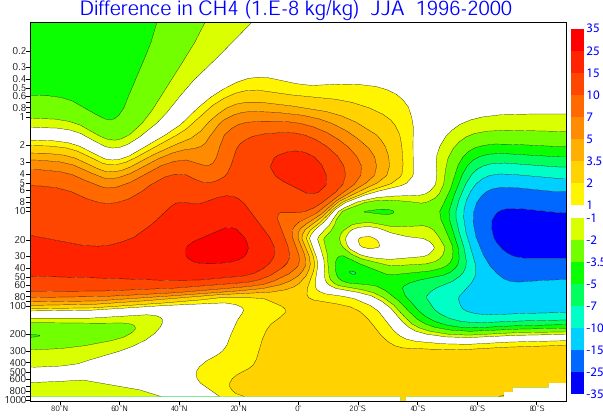
Fig. 11. Differences in the CH 4 concentrations (10 − 8 kgkg − 1 ) be- tween the CoMeCAT distribution and ECMWF GEMS climatology in the radiation scheme, averaged for June-July-August (JJA) 1996– 2000. Colour scale goes from most negative differences (dark blue) to most positive differences (dark